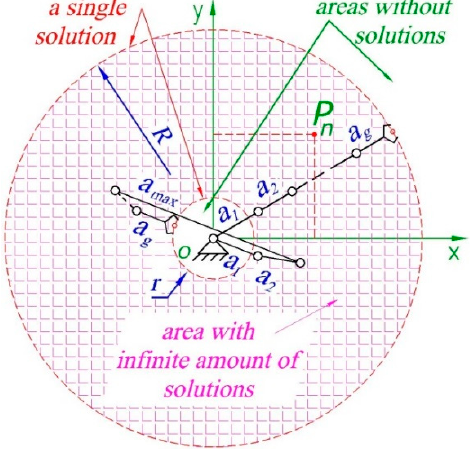
Figure 8. Reachable points without taking into account joint constraints.